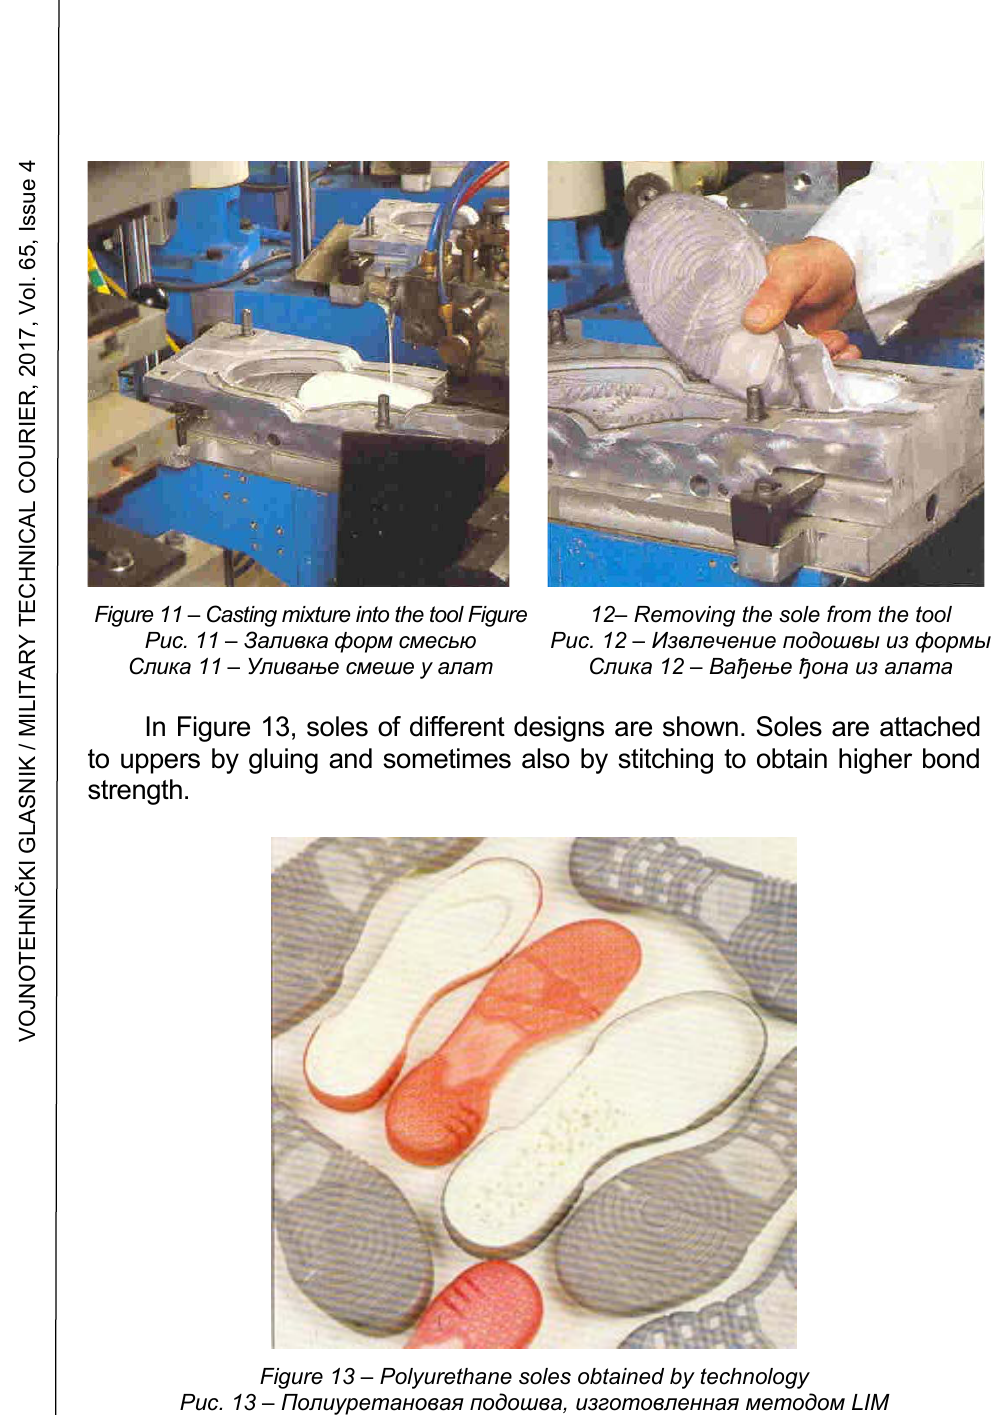
Figure 13 – Polyurethane soles obtained by technology Рис . 13 – Полиуретановая подошва , изготовленная методом LIM Слика 13 – Полиуретански ђонови добијени ЛИМ